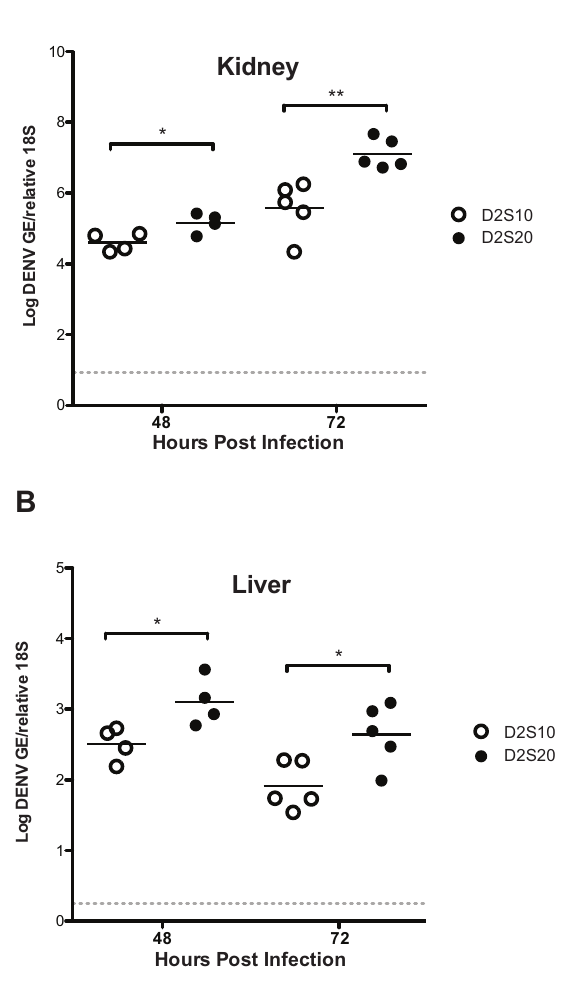
Figure 2. DENV replication in the liver and kidney after D2S10 and D2S20 infection. Viral RNA levels in (a) liver and (b) kidney were quantified by qRT-PCR 48 and 72 hours after infection (10 10 GE of DENV2 strain i.v. on day 0) D2S10 (white circles) and D2S20 (black circles). P values from two-tailed unpaired t test with Welch’s correction (95% confidence interval [CI]): * P is _ 0.05, and ** P is _ 0.01. Dashed lines denote limits of detection.